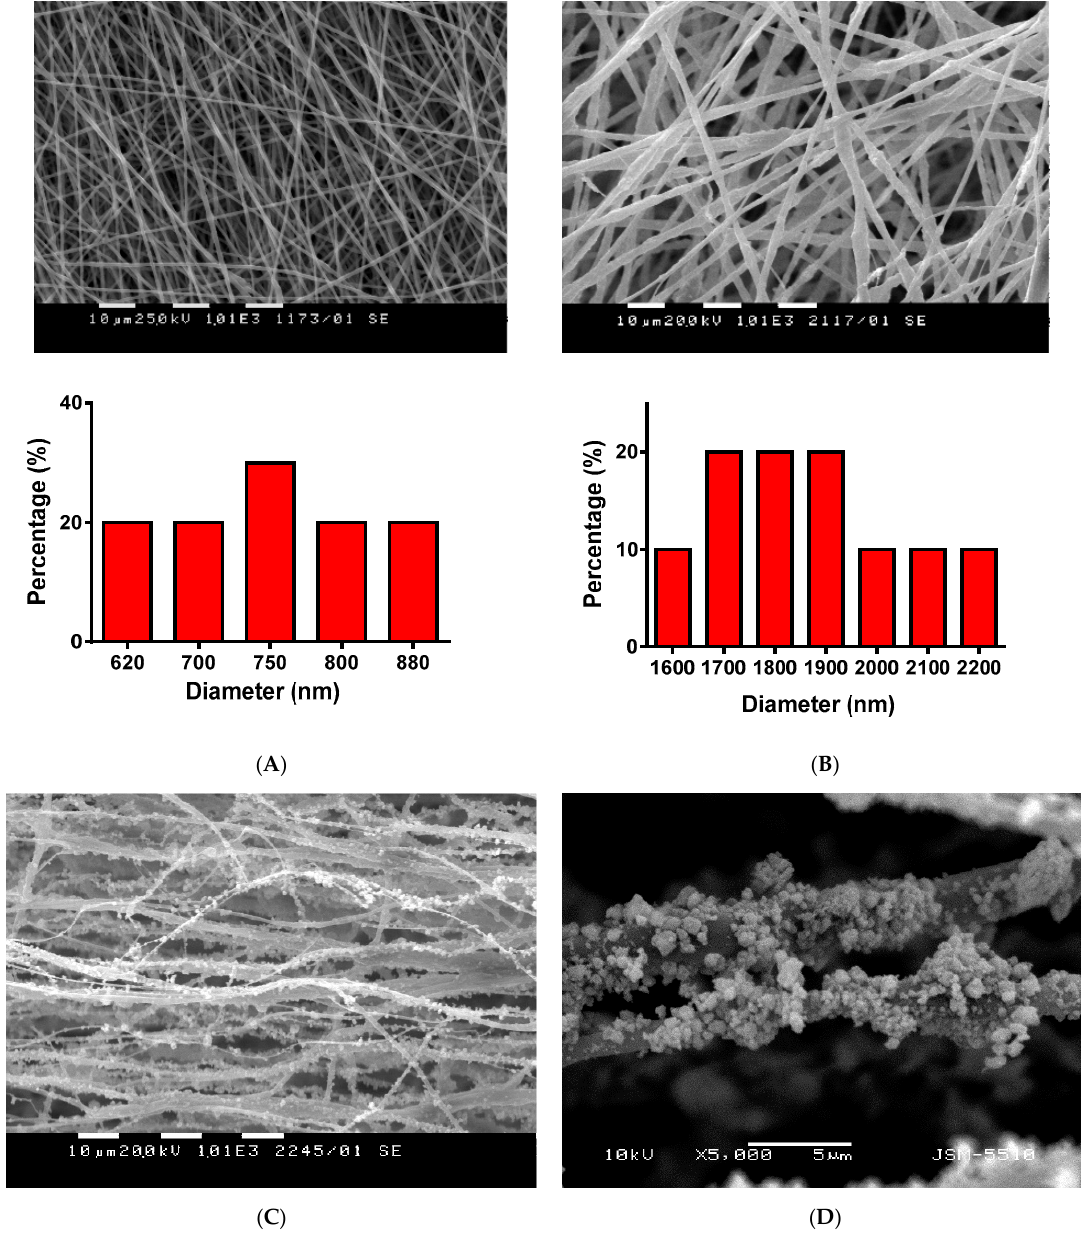
Figure 3. SEM micrographs of fibrous materials: ( A ) PHB ( × 1000), ( B ) TiO 2 - in -PHB ( × 1000), ( C ) TiO 2 - on -PHB ( × 1000) and ( D ) TiO 2 - on -PHB ( × 5000). The fiber diameter distributions are given for ( A ) and ( B ).